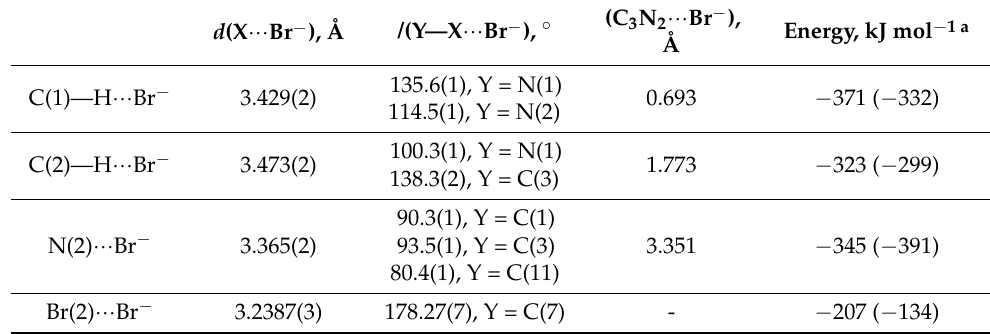
Table 1. Cation-anion interactions in the crystal structure of salt 3 .